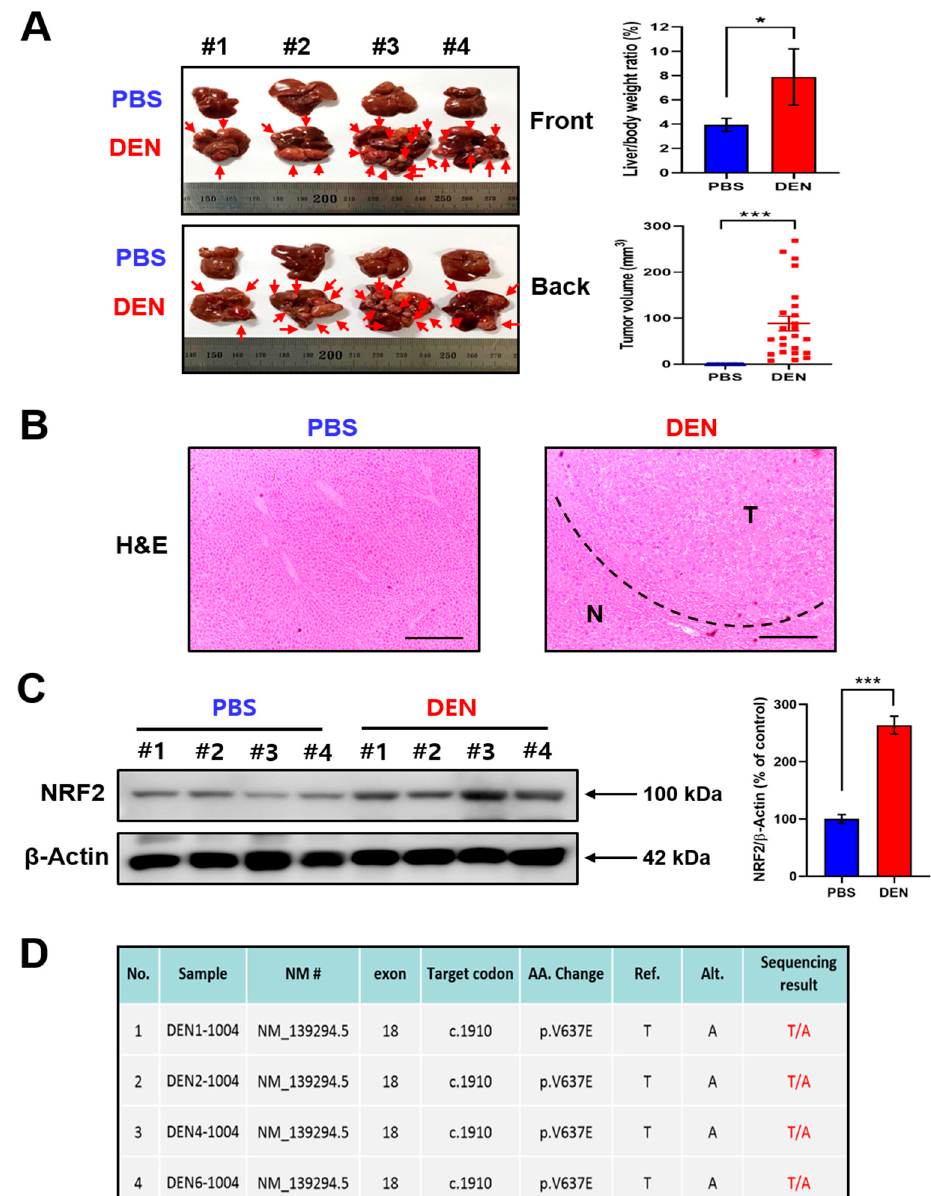
Figure 1. The elevated expression of NRF2 in DEN-induced hepatocarcinogenesis. ( A ) Two-week-old male mice ( n = 4) were given a single intraperitoneal dose of DEN (25 mg/kg) prepared in PBS. Control animals received PBS alone. Twelve months after DEN administration, mice were sacrificed, and livers were isolated. Body weight, liver weight, and tumor volume were measured, and statistical significance was determined by the Student’s t test. Data are shown as the mean ± SD ( n = 4). * p < 0.05; *** p < 0.001. ( B ) H&E staining was performed to determine the histologic difference in liver morphology between DEN-treated and vehicle-treated mice. N: normal tissue; T: tumor. Scale bar, 100 μ m. ( C ) The expression of NRF2 in the livers of DEN- and vehicle-treated mice was measured by Western blot analysis. Statistical significance was determined by Student’s t test. Data are shown as the mean ± SD ( n = 4). *** p < 0.001. ( D ) Total RNA samples were extracted from each group and converted to cDNA using reverse transcriptase following the standard procedure. After PCR amplification, Sanger sequencing was performed with BigDye ® Terminator v3.1 Cycle Sequencing Kit and analyzed by ABI PRISM 3730XL Analyzer.